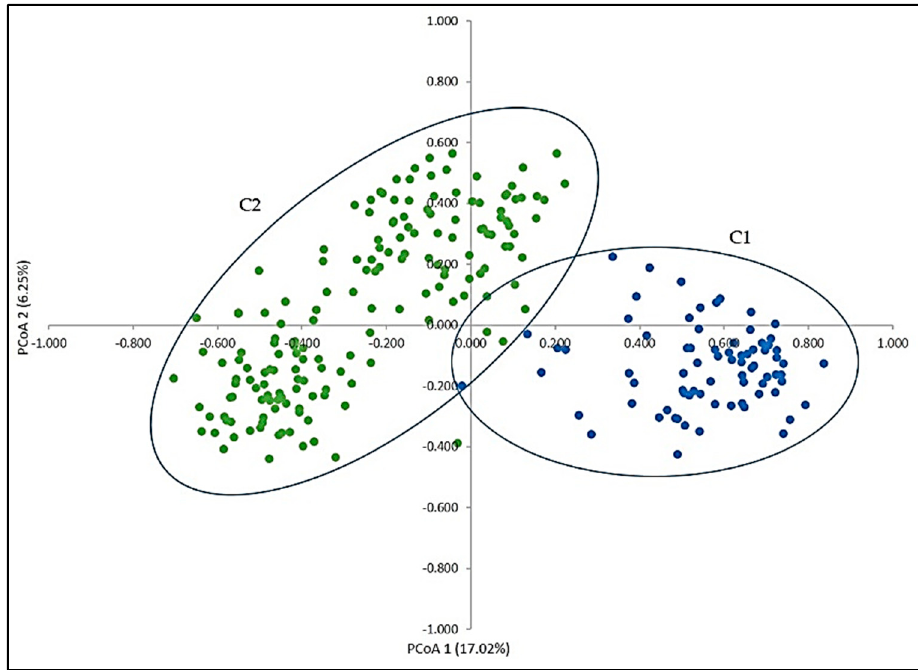
Figure 3. Principal coordinate analysis (PCA) of the 243 wild and cultivated samples represented by two axes using a covariance matrix of 20 SSR loci. Cultivated samples are represented in group C1 (blue) and wild samples are in group C2 (green).